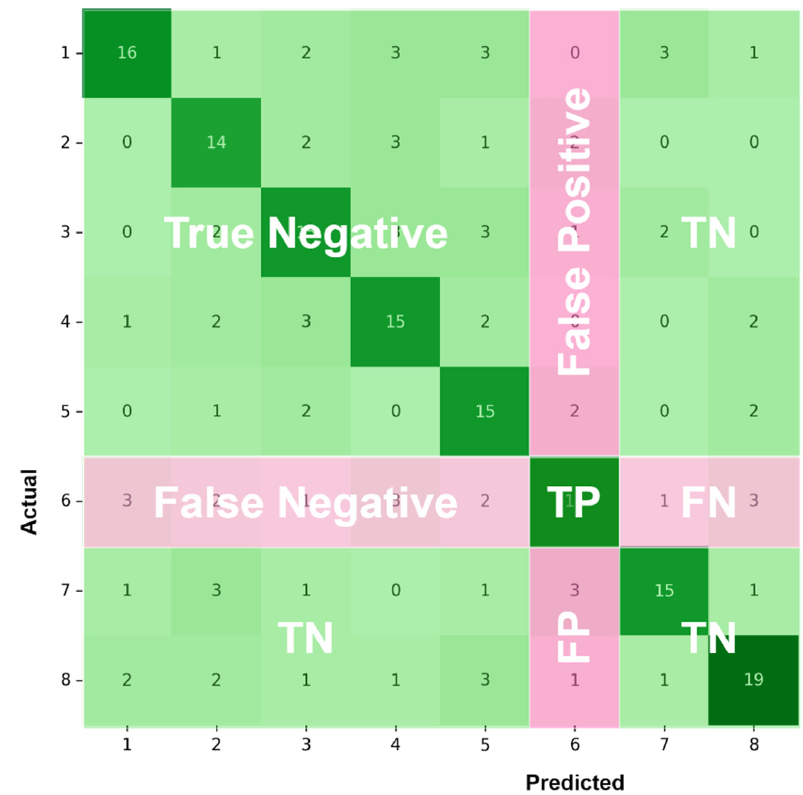
Figure 8. An 8 × 8 confusion matrix for illustrative purposes.